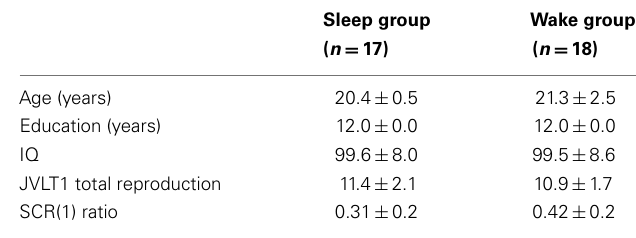
Table 1 | Demographic